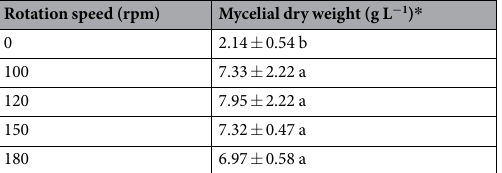
Table 3. Effect of rotation speed on the mycelial growth of Isaria farinosa . * Mean ± SE. Values followed by the same letters within a column do not differ significantly (ANOVA, P = 0.05).